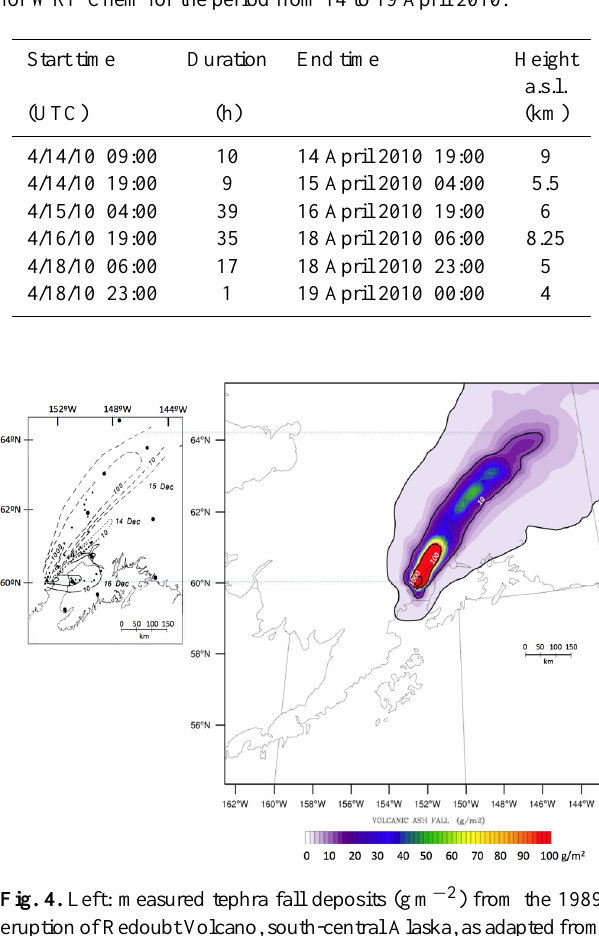
Table 3. The duration and height of the Eyjafjallaj¨okull plume used for WRF-Chem for the period from 14 to 19 April 2010.